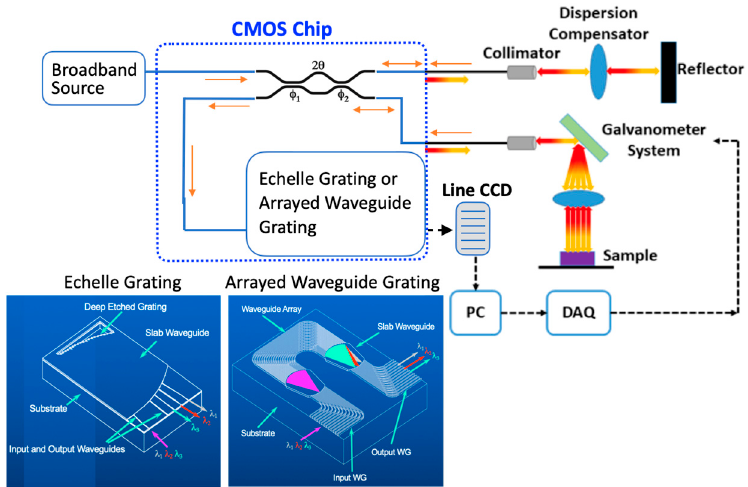
Figure 1. Optical coupler ‐ based SD ‐ OCT interferometer.